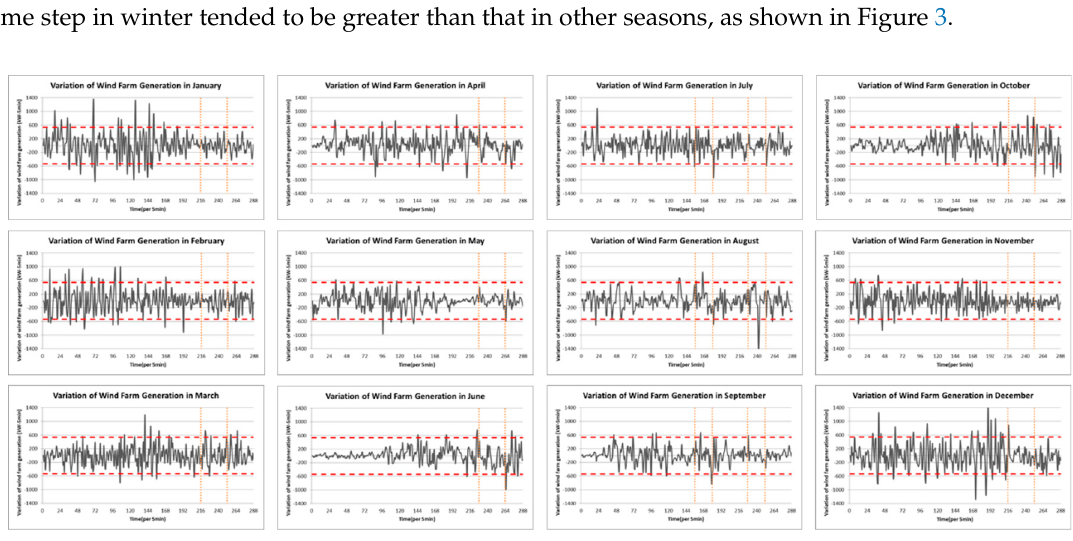
Figure 3. Profiles of wind power generation variation at each 5-min time step for each month based on one-year historical data at the Haengwon wind farm.